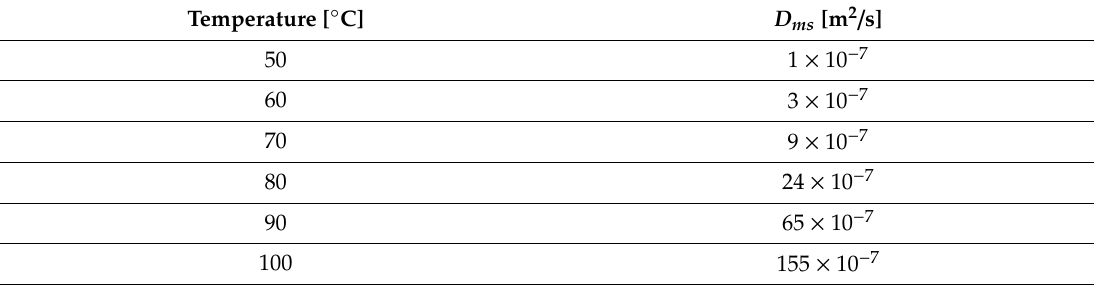
Table 2. Mass di ff usivities obtained with the